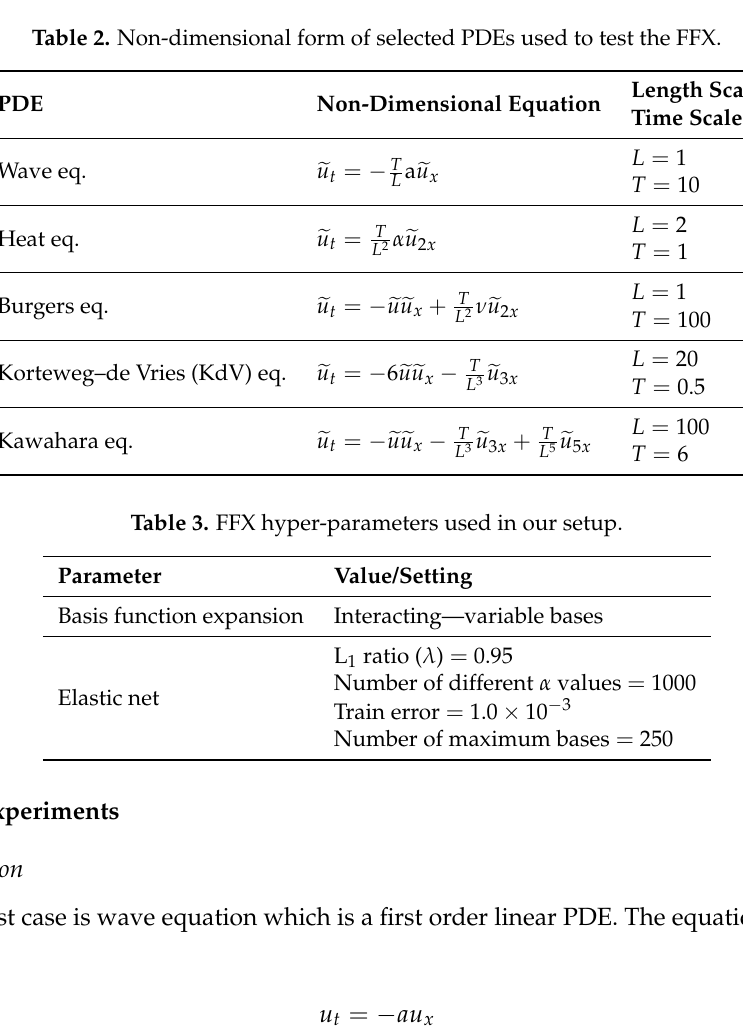
Table 2. Non-dimensional form of selected PDEs used to test the FFX. PDE Non-Dimensional Equation Wave eq.